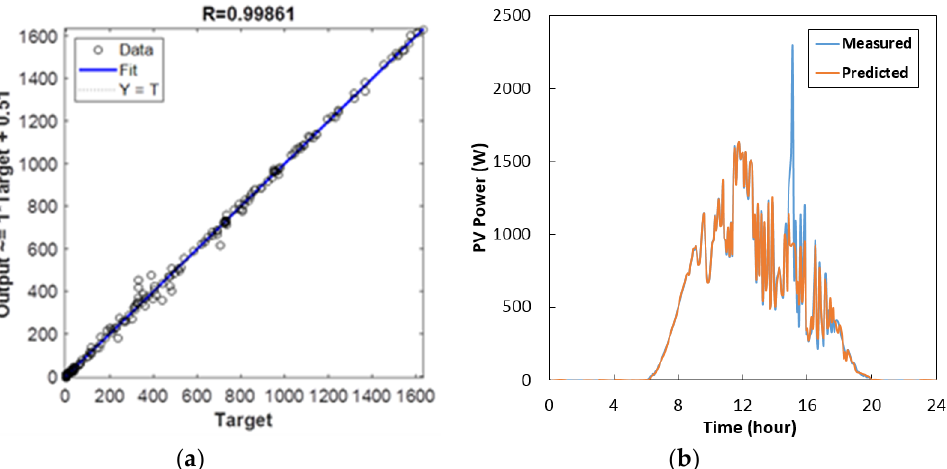
Figure 7. ( a ) Simulation result of a neural network with one hidden layer and 6 neurons and ( b ) machine learning (ML)— based prediction of photovoltaic (PV) power generation profile for 24 h on 15 May 2012, at the CCHT facility in Ottawa, ON, Canada.